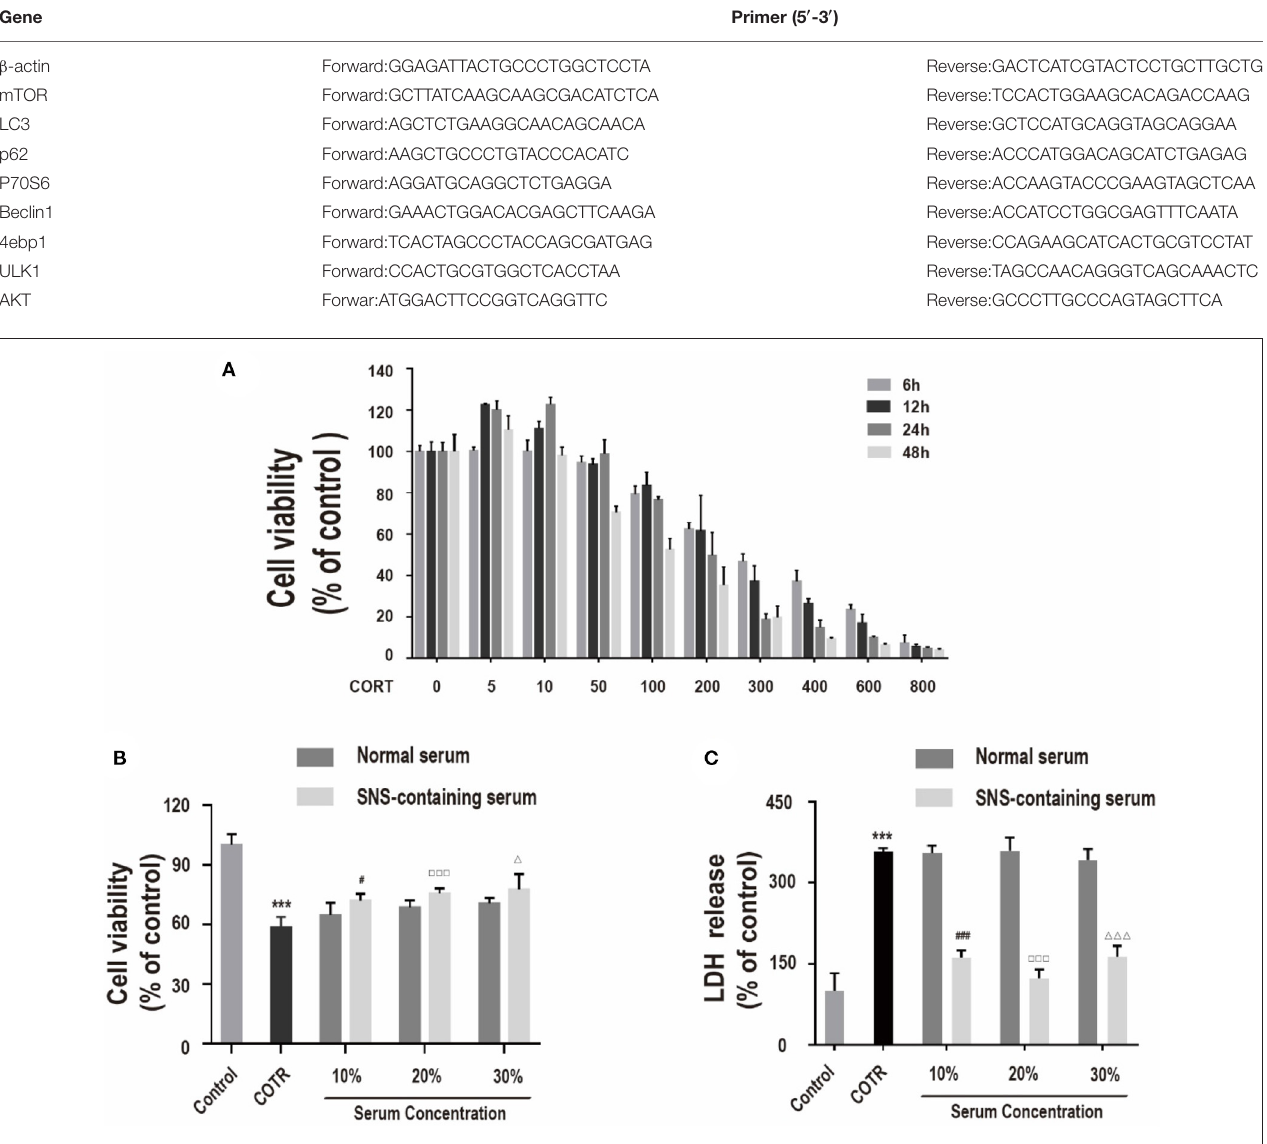
FIGURE 1 | (A) Viability of cells incubated with different concentrations of corticosterone (0, 5, 10, 50, 100, 200, 300, 400, 600, 800 µ M) for different intervals (6, 12, 24, 48h), determined by CCK-8 assay. ( n = 4). (B) Viability of cells co-incubated with 200 µ M corticosterone and 10%, 20%, or 30% SNS-containing serum for 24h. Each column represents mean ± SD ( n = 6). (C) LDH assay. ( n = 3) *** P < 0.01, vs. control group; # P < 0.05, ### P < 0.01 vs. 10% normal serum group; (cid:3)(cid:3)(cid:3) P < 0.01 vs. 20% normal serum group; 1 P < 0.05, 111 P < 0.01 vs. 30% normal serum